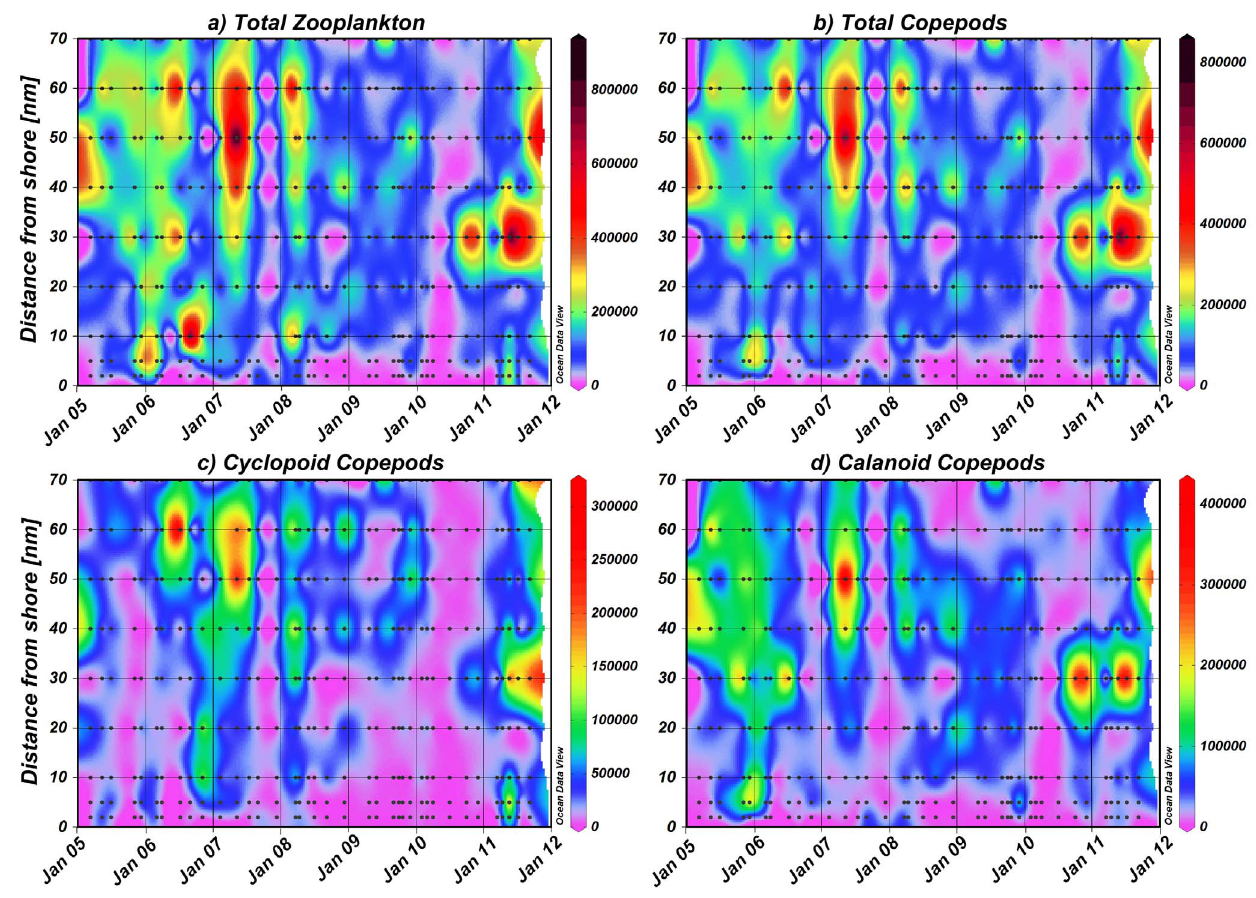
Figure 6. Abundance (no. m 2 2 ) and distribution of a) total zooplankton, b) total copepods, c) cyclopoid copepods and d) calanoid copepods shown for each year along the